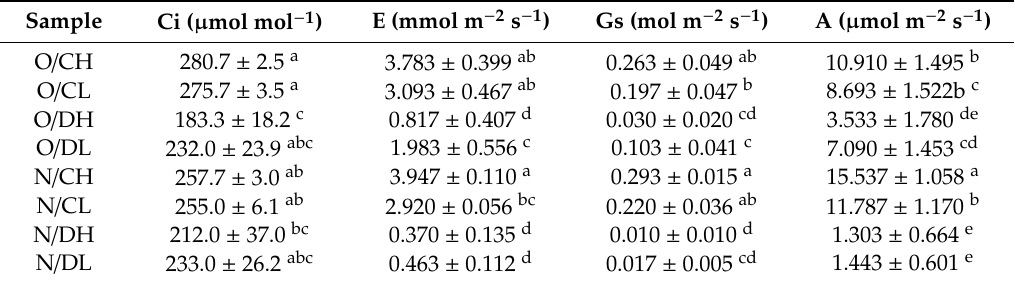
Table 1. The results of the analysis of plant photosynthesis (PAR = 400 µ mol m − 2 s − 1